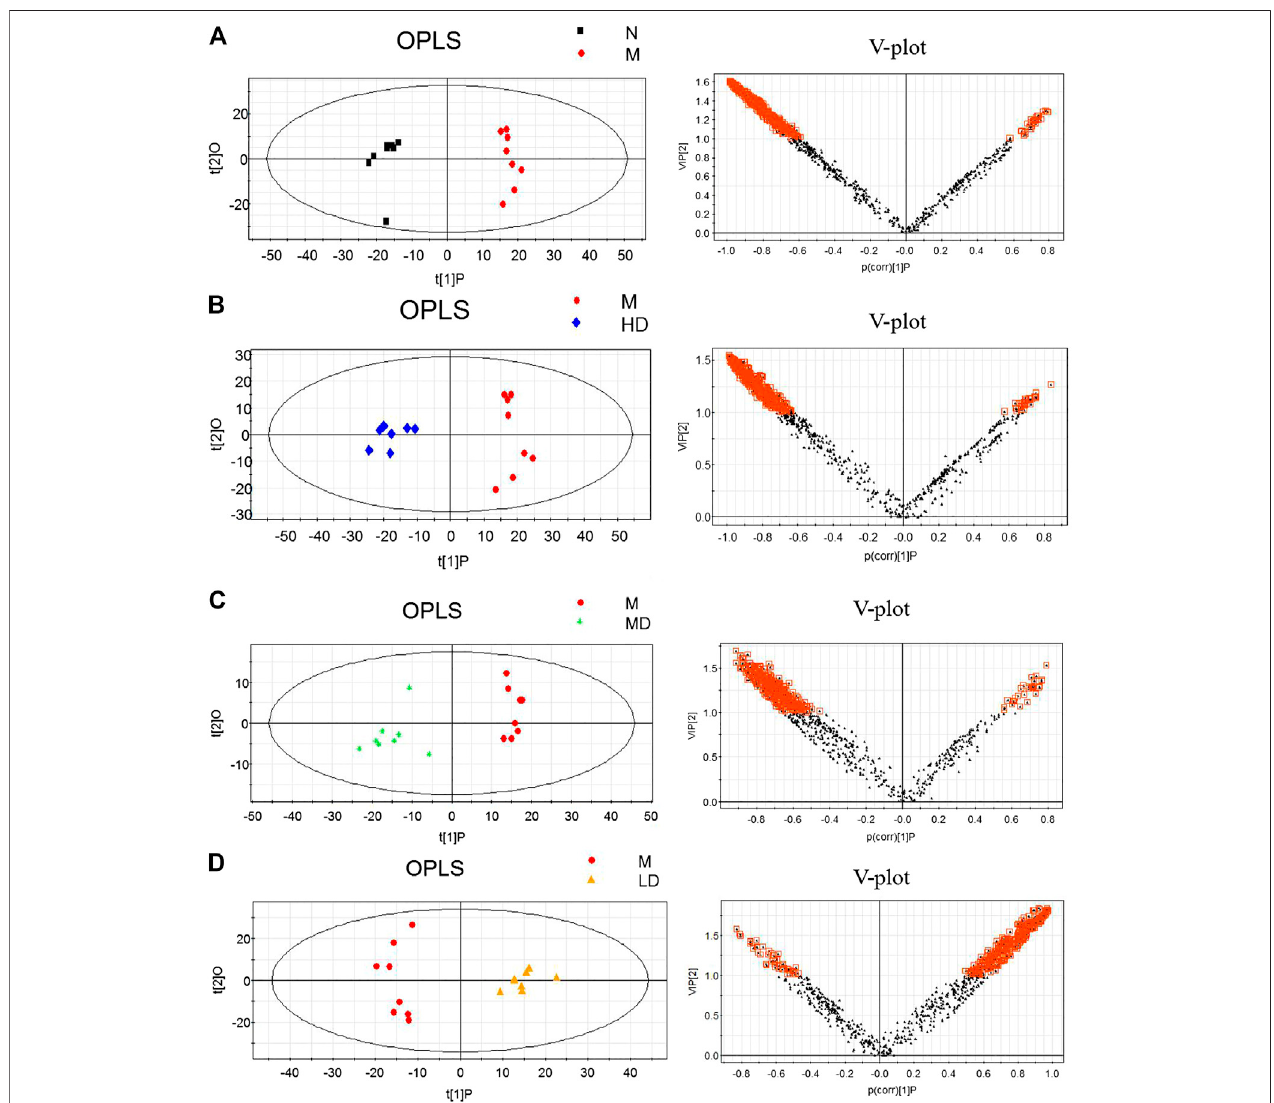
FIGURE 5 | Orthogonal partial least squares-discriminant analysis (OPLS-DA) score plots (left) and corresponding loadings plots (right). (A) M group vs. N group, (B) HD group vs. M group, (C) MD group vs. M group, and (D) LD group vs. M group.